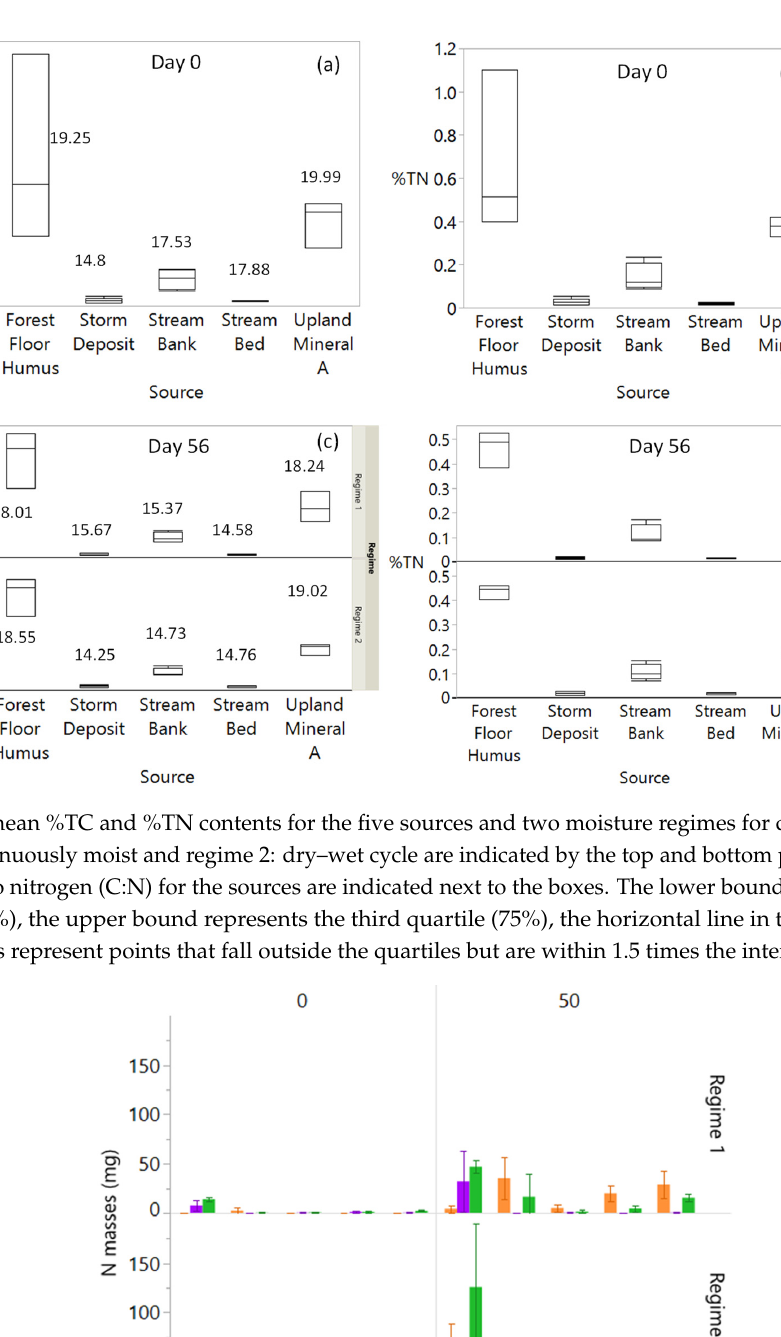
Figure 5. Porewater mass of DOC for the five sources and two moisture regimes for day 0 and day 50. Regime 1: continuously moist and regime 2: dry–wet cycle. Porewater N (Figure 6) and DOC (Figure 7) masses varied temporally across sources and moisture regimes. In general, porewater TDN increased throughout the incubation across all sources, with the greatest increase for forest floor humus. The temporal changes of porewater TDN were largely driven by changes in porewater nitrate ‐ N. Forest floor humus, however, also indicated sharp increases in ammonium ‐ N and DON across both